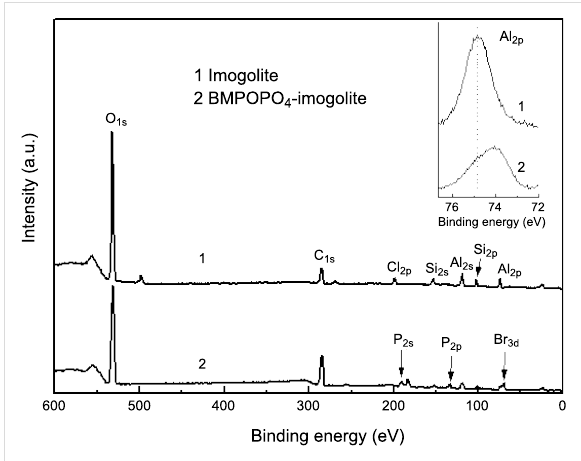
Figure 12: Wide-scan XPS spectra of the original imogolite and BMPOPO 4 -imogolite (inset, high-resolution XPS spectra of Al 2p ). Reprinted with permission from W. Ma et al., Polymer 2011, 52, 5543–5550 [53]. © 2011, Elsevier B.V.